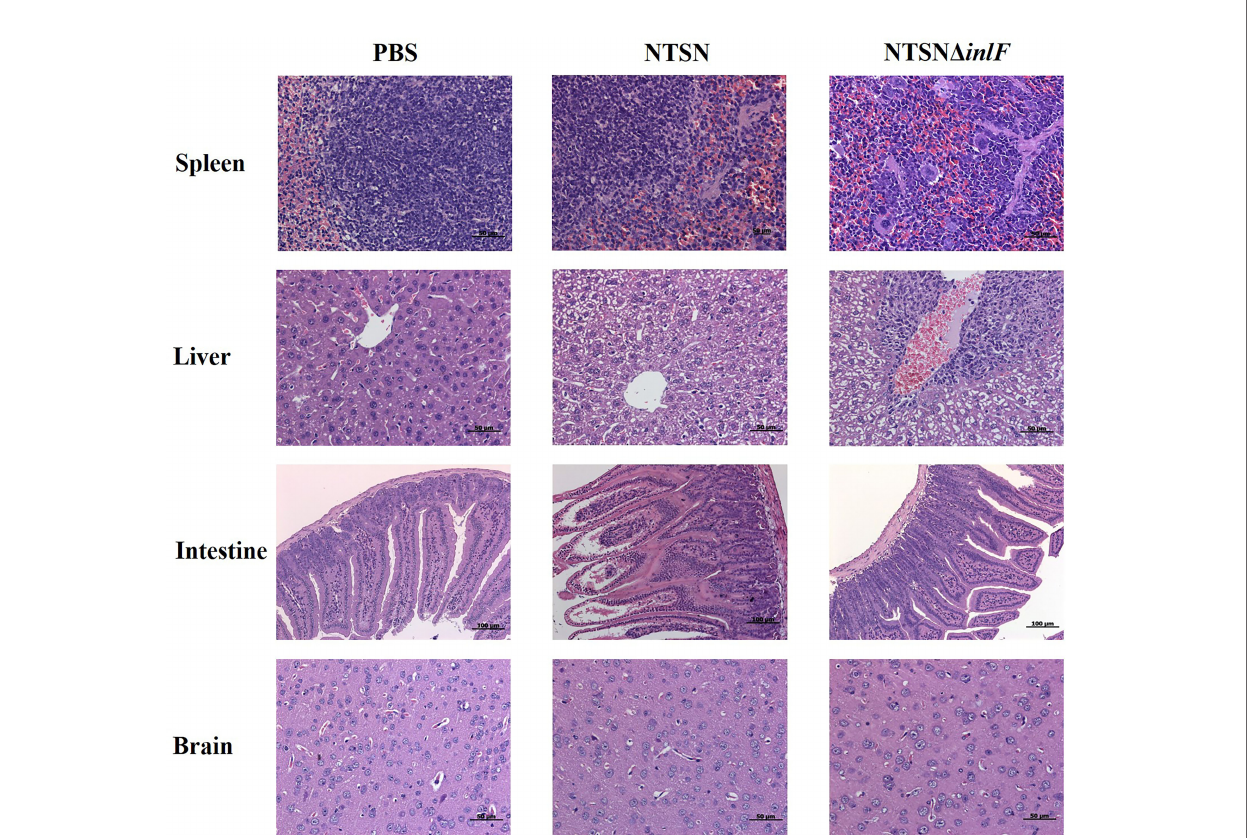
FIGURE 6 | Histopathological section of infected mice organs. Six-week-old female mice were randomly assigned to 3 groups as follows to receive either NTSN or NTSN D inlF combined with PBS as a control. Experiments were performed at 72 h post-infection. Sections of the spleens, livers, ileum, and brains are shown at the same magni fi